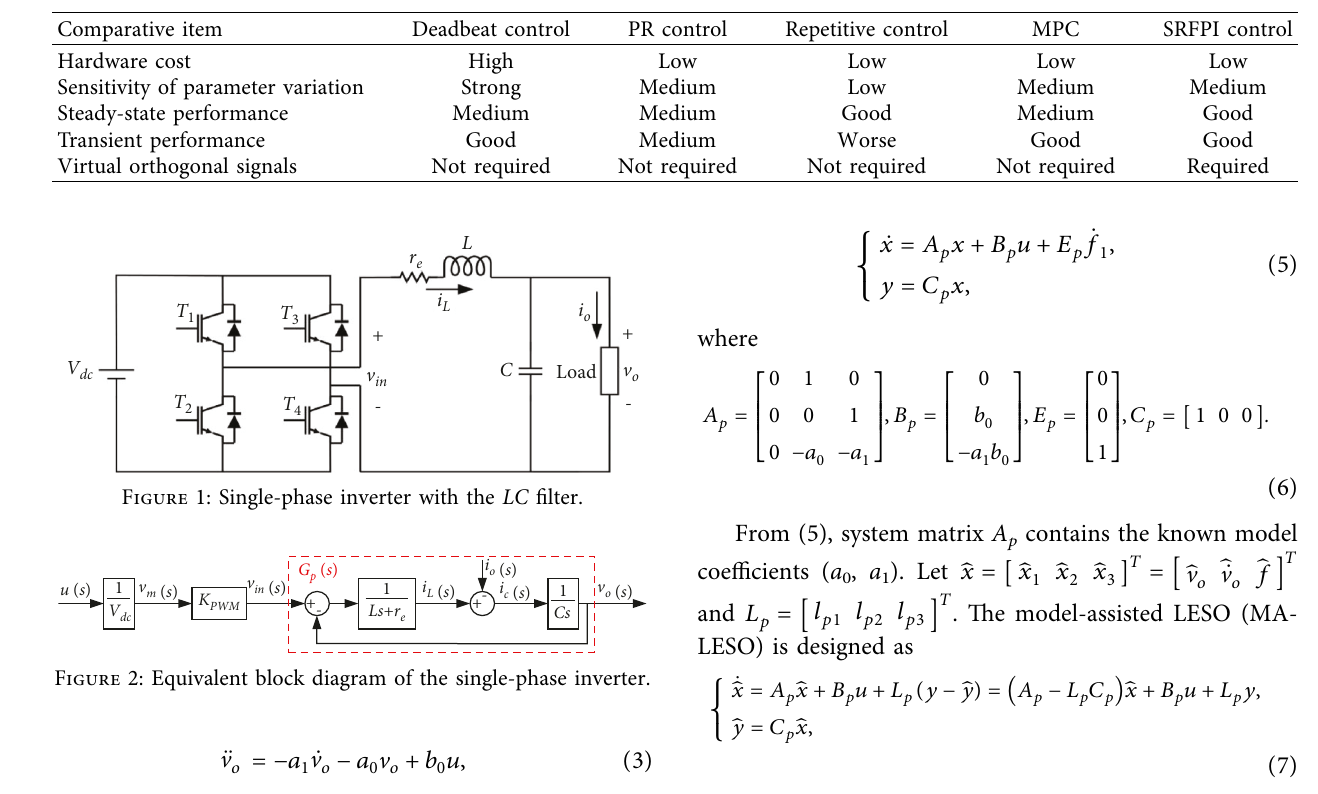
Table 1: Feature comparison of control schemes for single-phase inverters.